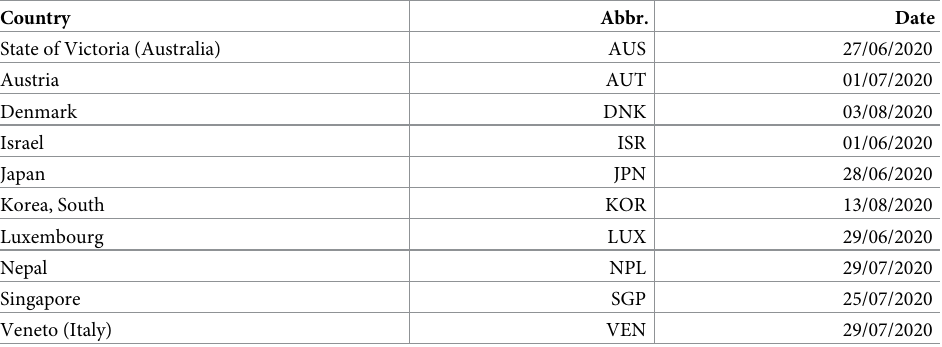
Table 1. Selected countries for the dataset, abbreviations and date of second epidemic insurgence. Refer to “Data Collection and Curation” for how the date marking the second wave is obtained.